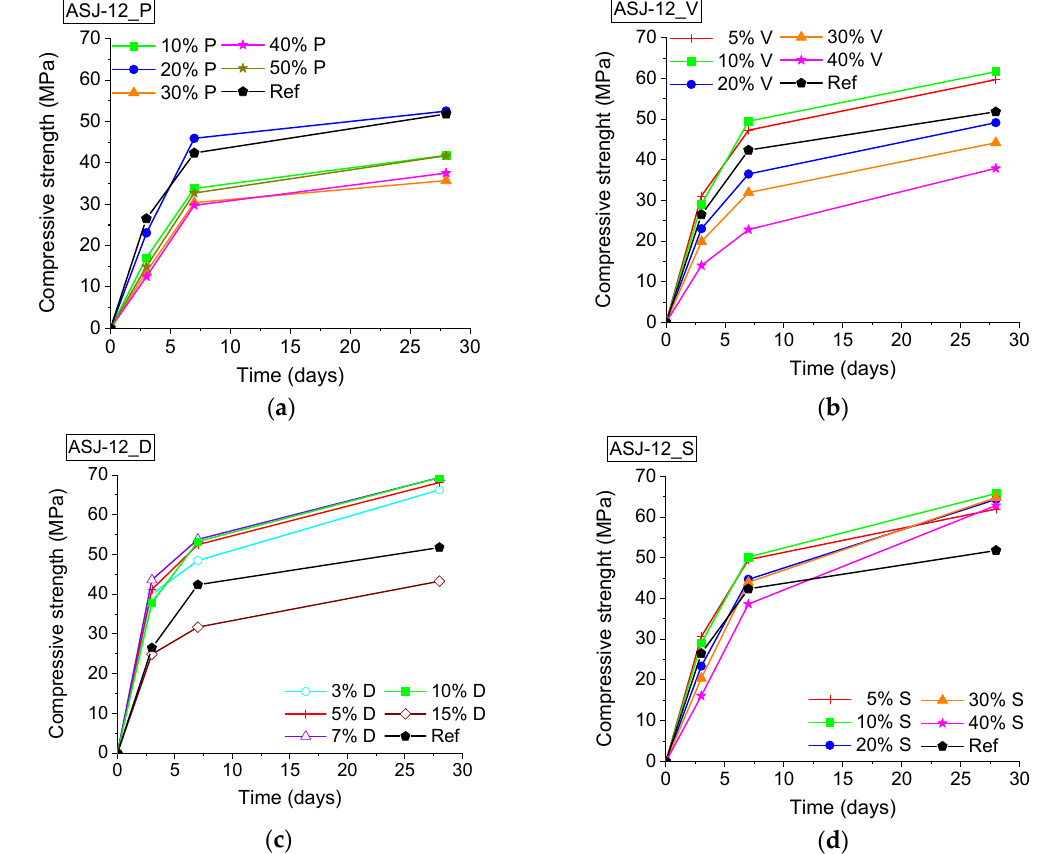
Figure 4. Compressive strength results of the mortars made with the reactive siliceous pebbles, ASJ_12, and four additions mixed in four percentages of 20%, 30%, 40% and 50%: ( a ) natural pozzolan, P; ( b ) siliceous coal fly ash, V; ( c ) silica fume, D; ( d ) blast-furnace slag, S.